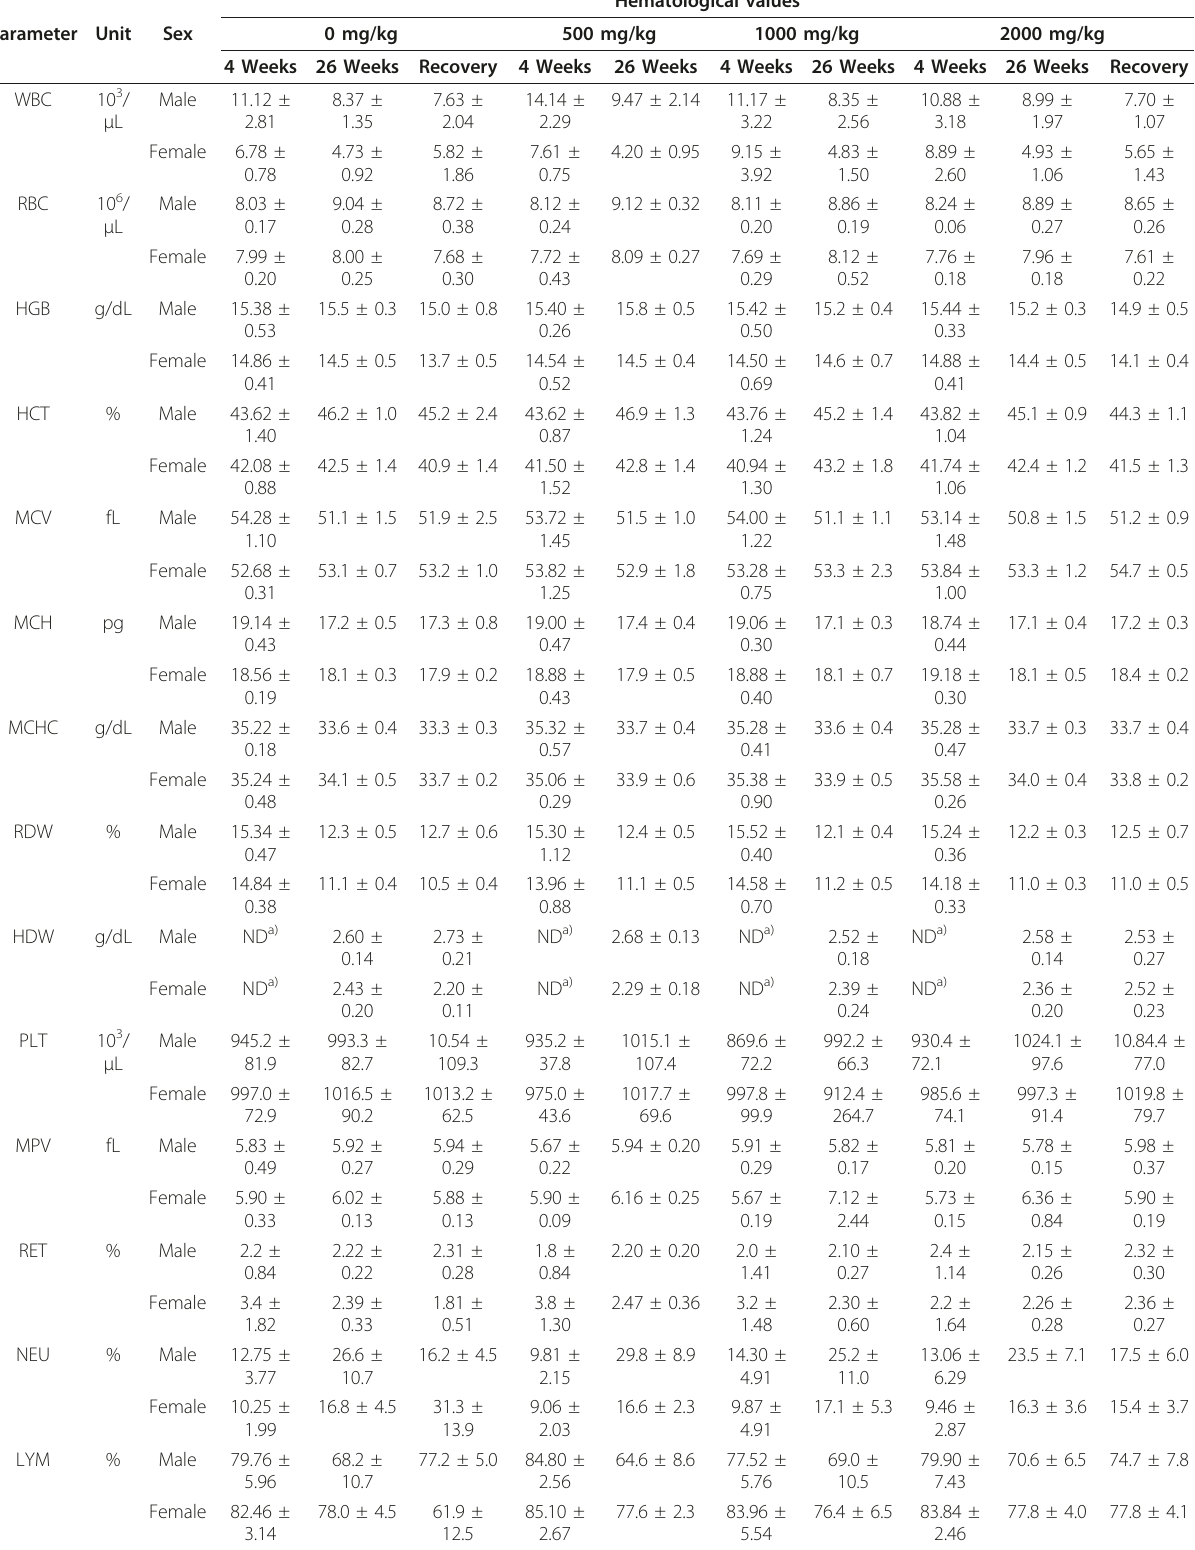
Table 3 Hematological values in rats orally treated with